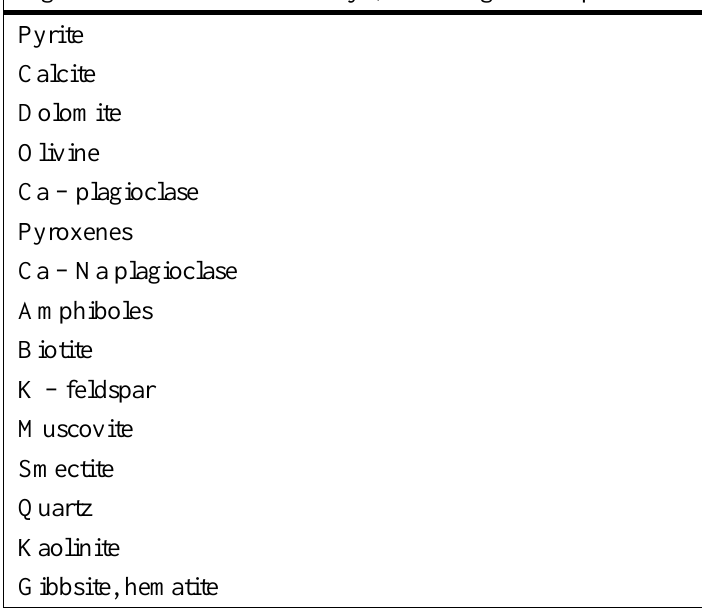
Fig. 2 – Lateritic profile of a tropical soil (Melfi et al. 1999). Fig. 3 – Mineral weatherability (decreasing from top